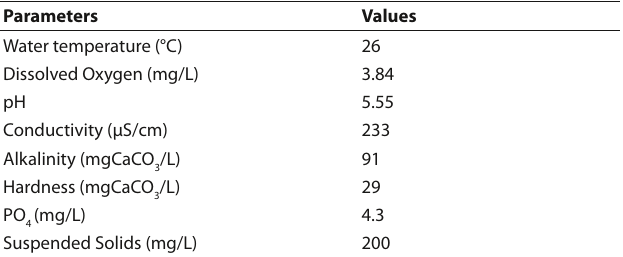
Table 1. Physicochemical parameters of the Azuceno Wetland, Guamo municipality, Tolima Department,